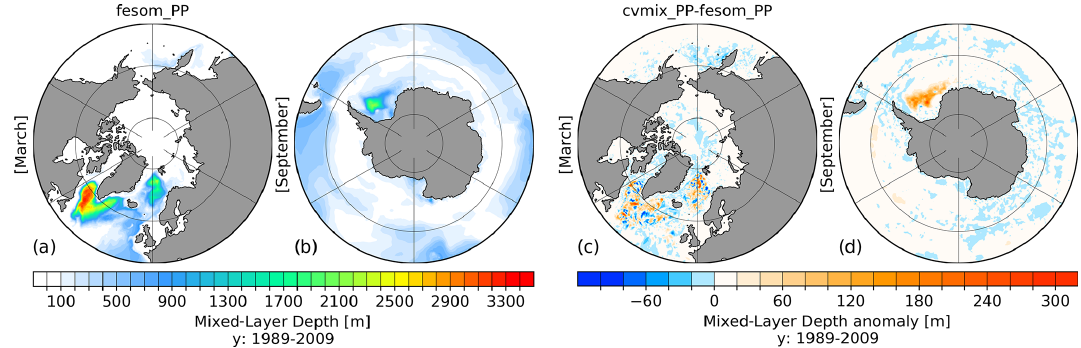
Figure 12. Northern Hemisphere March (a) and Southern Hemisphere September (b) mixed-layer depth (MLD) for fesom_PP implementa- tion and the corresponding anomalous MLD between cvmix_PP and fesom_PP implementation (c, d) averaged for the period 1989–2009.